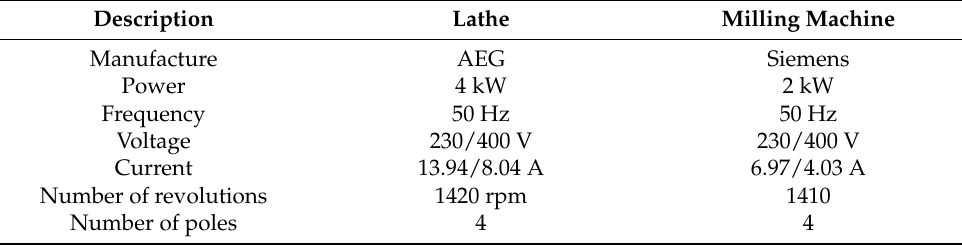
Figure 9. Lathe ( left ) and milling machine ( right ) tested. Table 1. Characteristics of the Electrical Motor tested.